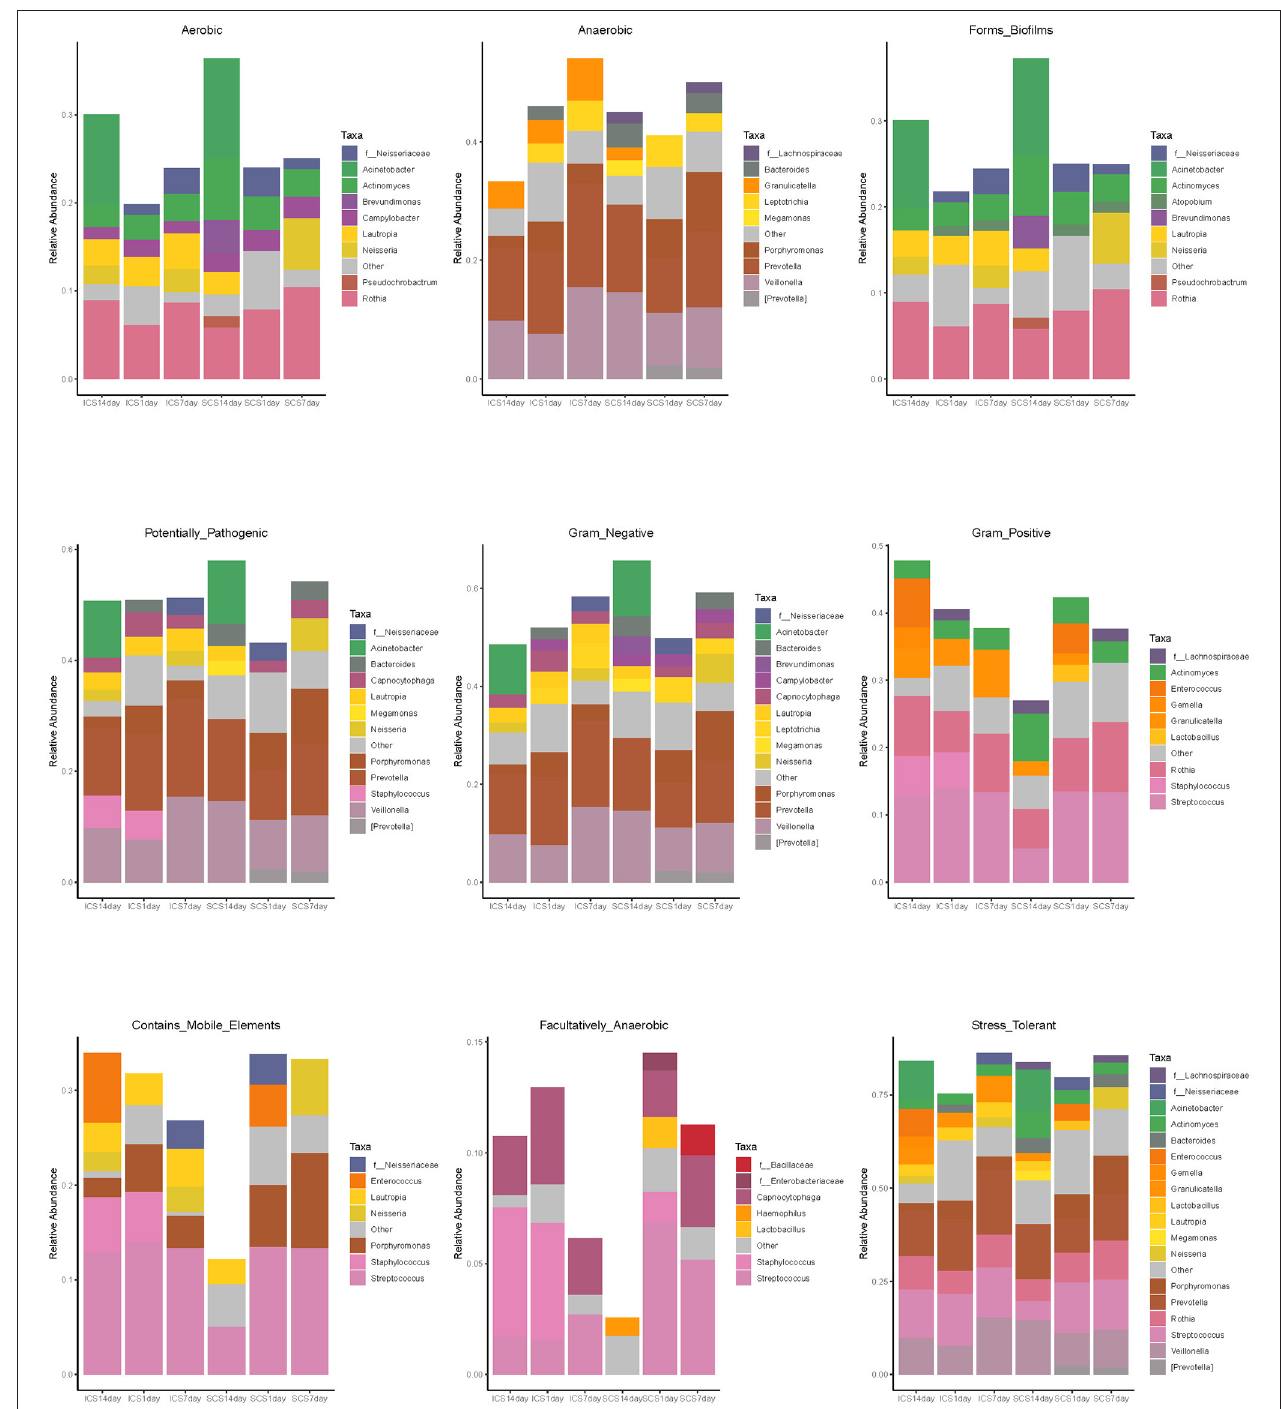
FIGURE 11 | Bacterial composition of each group predicted by BugBase. Bacterial composition of each group, including Gram Positive, Gram Negative, Biofilm Forming, Pathogenic Potential, Mobile Element Containing, Oxygen Utilizing, and Oxidative Stress Tolerant.